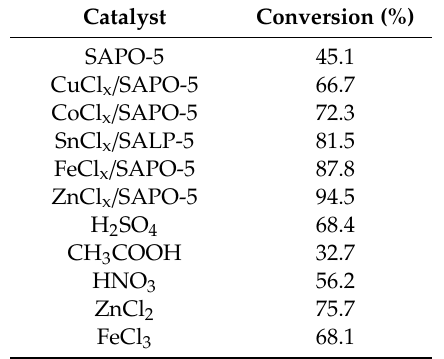
Table 5. Catalytic comparison study between MCl x / SAPO-5 and some common homogeneous catalysts in acylation of 2-methylfuran a . Catalyst Conversion (%)